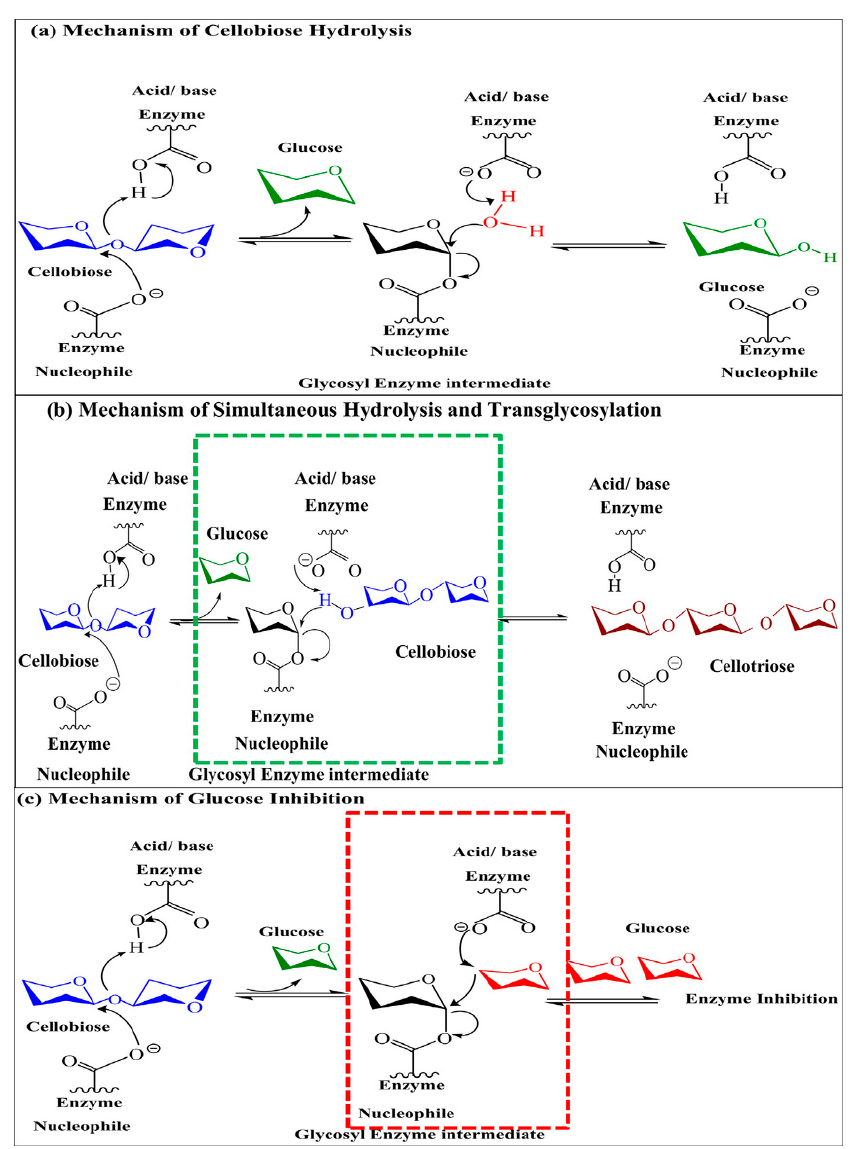
Figure 3. Schematic representation of the β -glucosidase mechanism of action: ( a ) hydrolysis, ( b ) simultaneous hydrolysis and transglycosylation, and ( c ) glucose inhibition. The transient glycosyl enzyme intermediate (E-Glu1*) is represented in the green box, while the glucose inhibited state (E-Glu) is represented in the red box (adopted with permission from the authors of [151], and also credit to [153]).